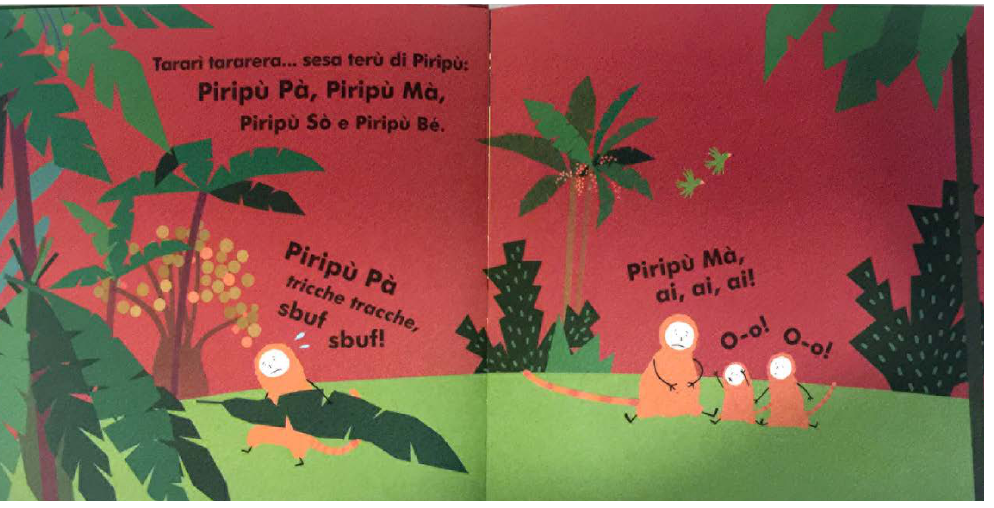
Fig. 18 Emanuela Bussolati, Piripu Bibi ,